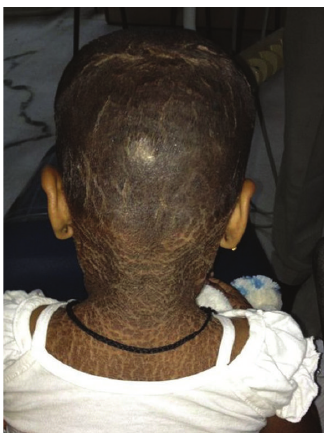
Figure 2: Scaly lesions present in scalp.